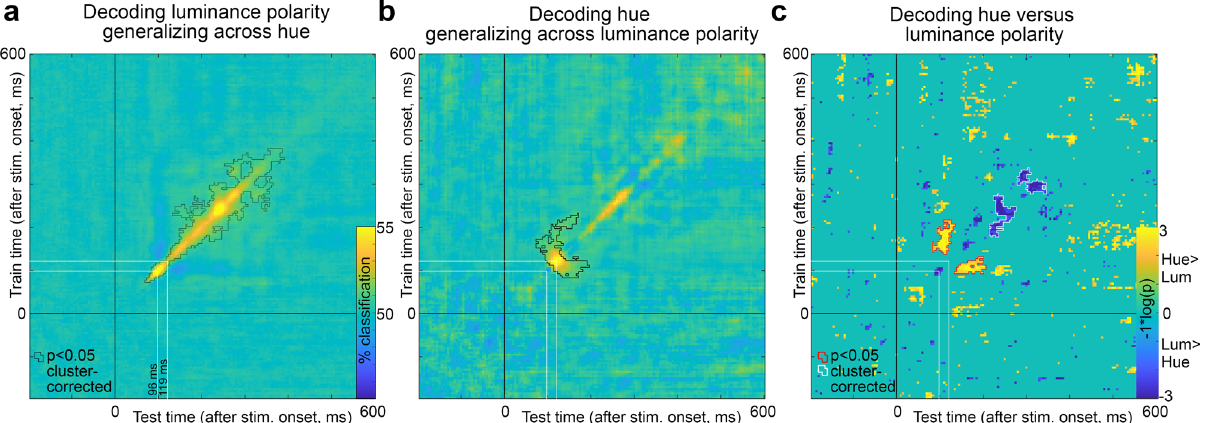
Fig. 6 Cross-temporal generalization of decoding luminance polarity versus hue. a Classi fi ers were trained using the pattern of MEG activity elicited at time points from − 200 ms to 600 ms after stimulus onset ( y -axis) and tested using data not used in training across the same time interval, on the set of problems decoding luminance polarity generalizing across hue. The best decoding performance was achieved with classi fi ers that were trained and tested using data from the same time point after stimulus onset, indicated by the strong performance along the x = y diagonal. The peak classi fi cation time was at 100 ms; there was a dip in classi fi cation performance at about 120 ms. The black contours show regions in the heatmap that were p < 0.05 cluster corrected. The p values were obtained using a sign-permutation test. b Data as in a , but for classi fi ers trained and tested on the set of problems decoding hue generalizing across luminance polarity. The peak classi fi cation time was 119ms; the cluster-corrected regions of signi fi cance extended further from the diagonal compared to a . c Comparison of results in a and b . The time points where the classi fi ers were more accurate for luminance polarity compared to hue are shown as dark blue (white contours show cluster-corrected signi fi cant results), while the time points where the classi fi ers were more accurate for hue compared to luminance polarity are shown as yellow (red contours show cluster-corrected results). The p values were obtained using a permutation test on the difference in accuracy between hue and luminance polarity decoding. The p values are cluster corrected. Decoding of hue showed greater generalization across time compared to decoding of luminance polarity, and the greater cross-temporal generalization for hue began relatively early after stimulus onset (~119